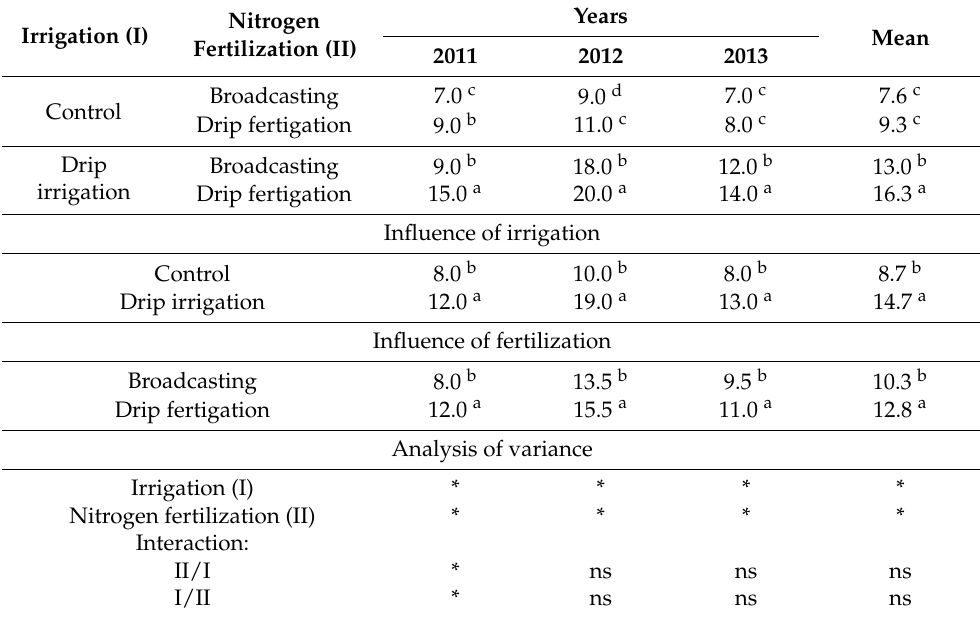
Table 8. The number of tubers per plant (pcs) of potato cultivar Courage in 2011–2013.